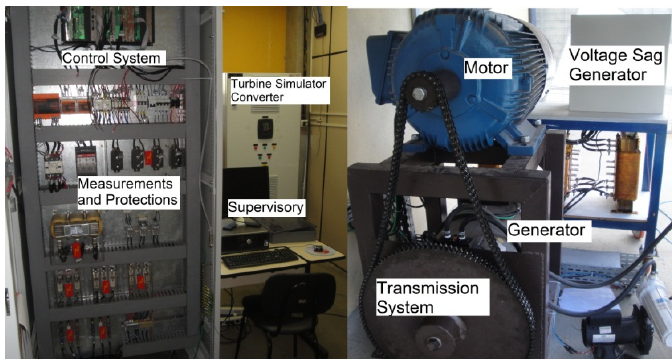
Figure 5. Pictures of the scaled 34 kW test bench representing a FC ‐ PMSG.